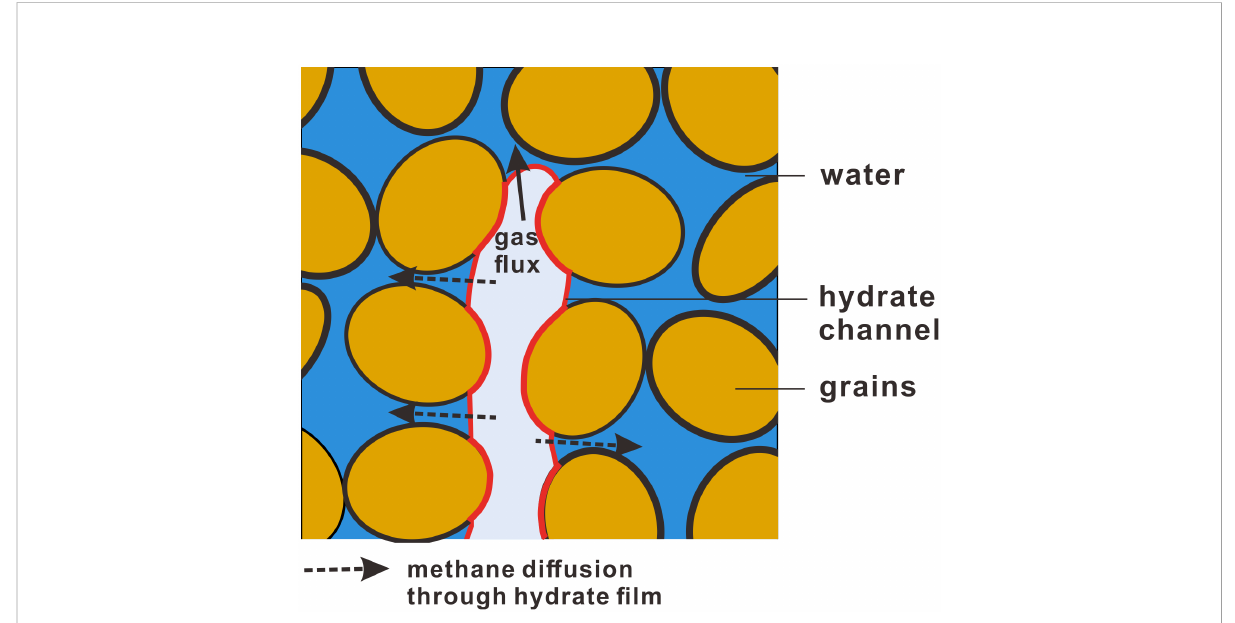
FIGURE 6 Schematic of gas fl ow through a hydrate channel [modi fi ed from Meyer et al.